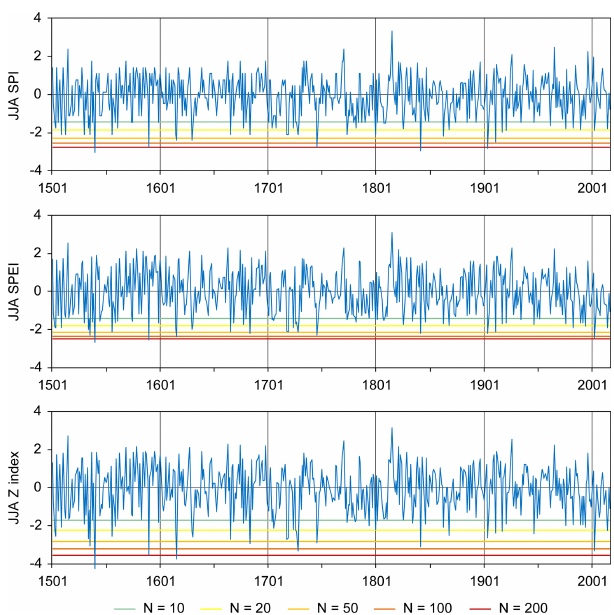
Figure 3. Box plots (maximum and minimum, upper and lower quartile, mean) of Czech drought indices (a) , central European tem- peratures (b) and Czech precipitation (c) in MAM, JJA and SON: 1 – dry years with N ≥ 20 years; 2 – remaining years 1501–1803. Temperatures and precipitation are expressed as anomalies with re- spect to the 1961–1990 reference